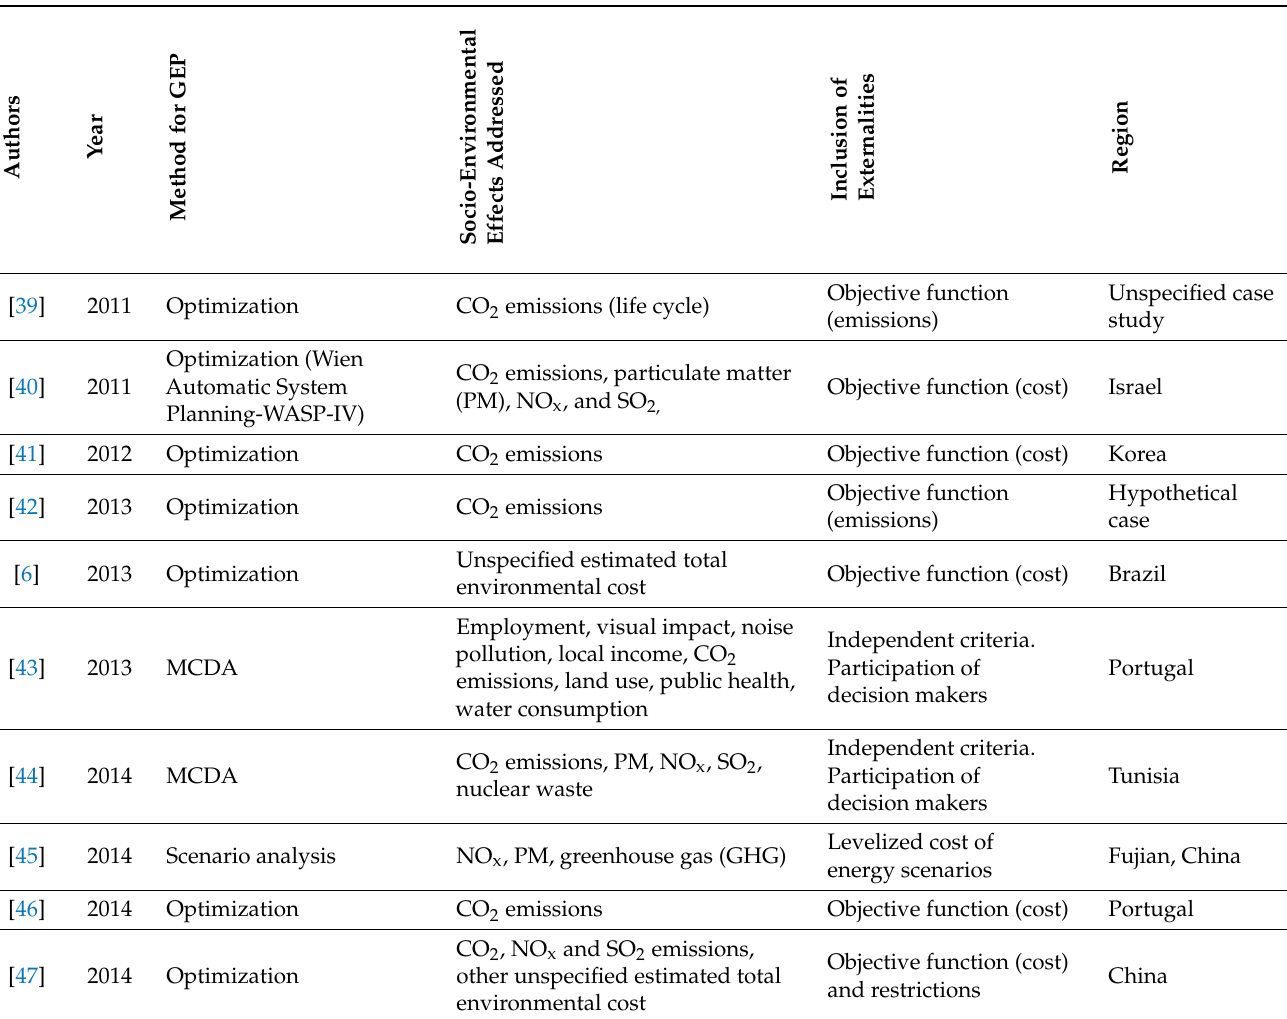
Table 2. Reviewed studies on the internalization of externalities in